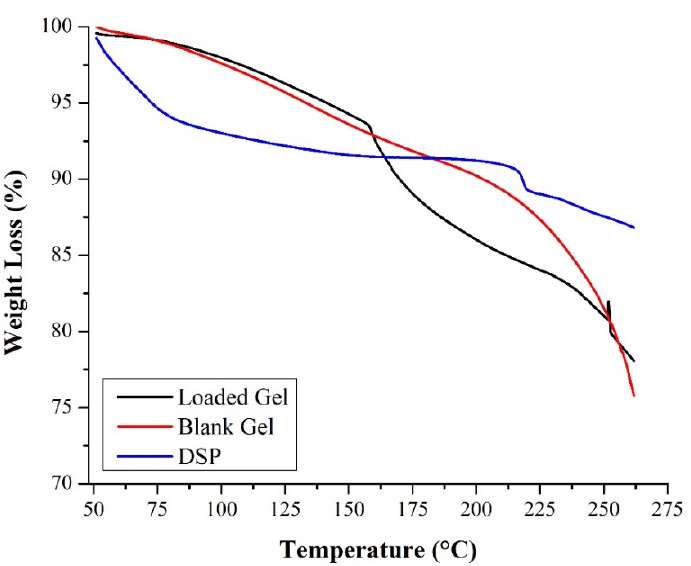
Figure 6. Thermogravimetric analysis of DSP, blank, and DSP-loaded semi-IPN hydrogel matrices (AP-8).